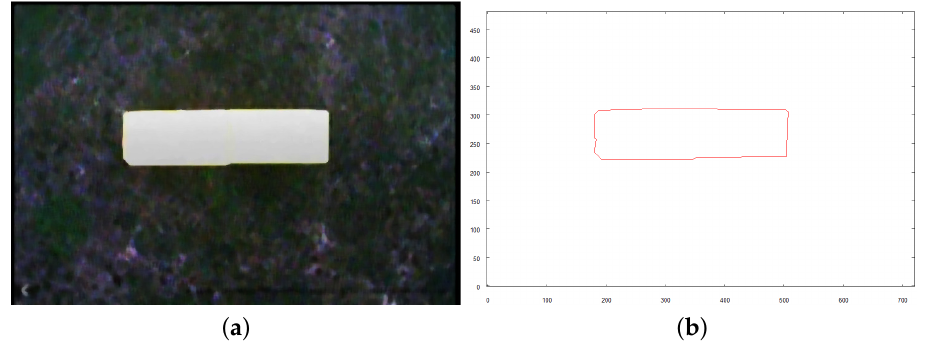
Figure 27. Image of TOP side of structure. ( a ) preprocessed image; ( b ) vectorized